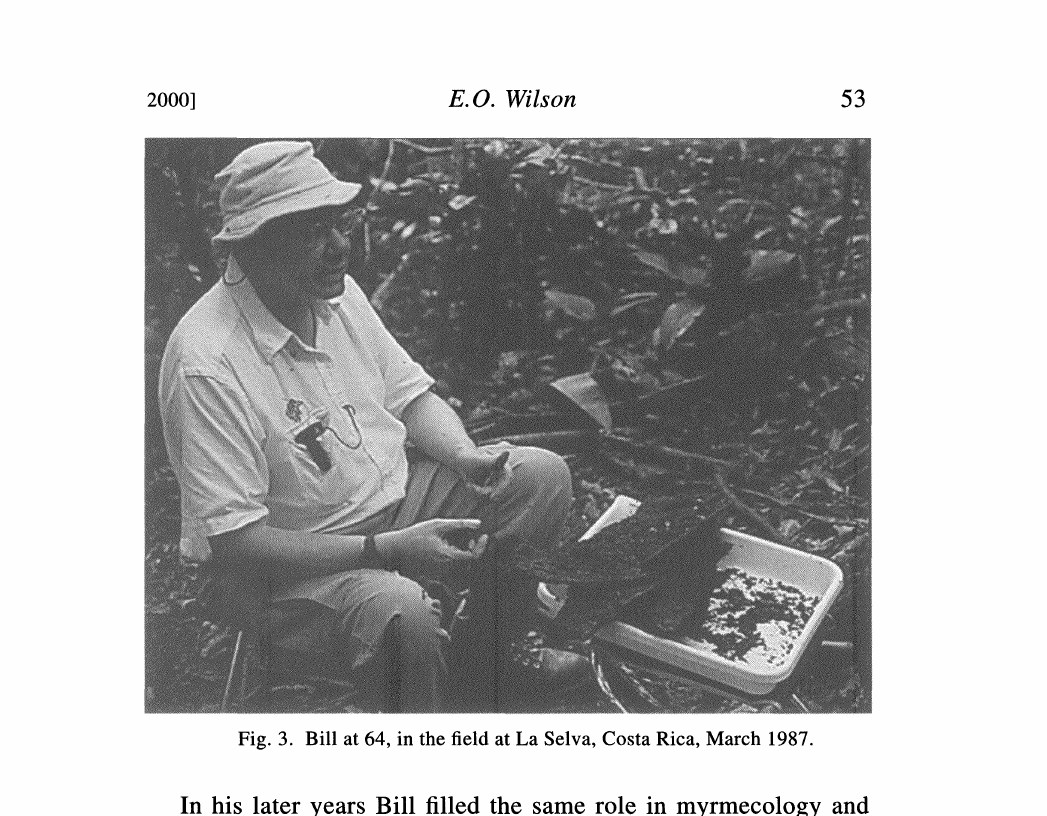
Fig. 3. Bill at 64, in the field at La Selva, Costa Rica, March